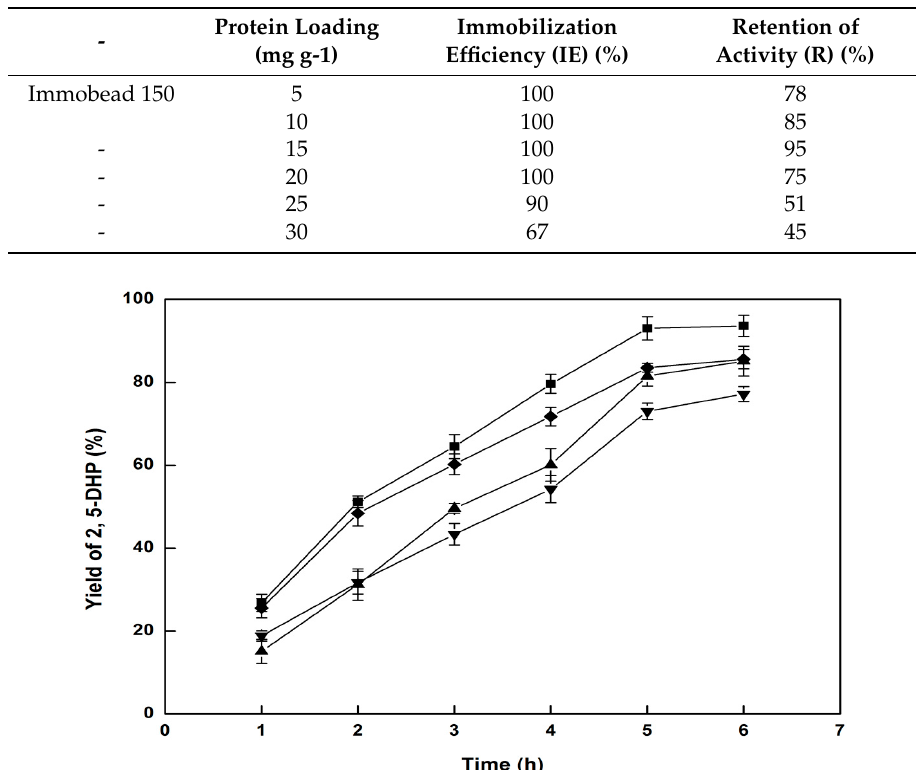
Figure 1. Synthesis of 2,5-dihydroxypyridine (2,5-DHP) by Immobead 150 (ImmHSPH ZZ ) at protein loading of ( ▲ ) 5, ( ◆ ) 10, ( ■ ) 15 and ( ▼ ) 20 mg g − 1 . The reactions were performed in 20 mM Tris-HCl buffer (pH 9.0) containing 0.75 mM HSP, 30 mg/mL ImmHSPH ZZ , 10 mM FAD and 0.5 mM NADH at 35 °C for 30 min.